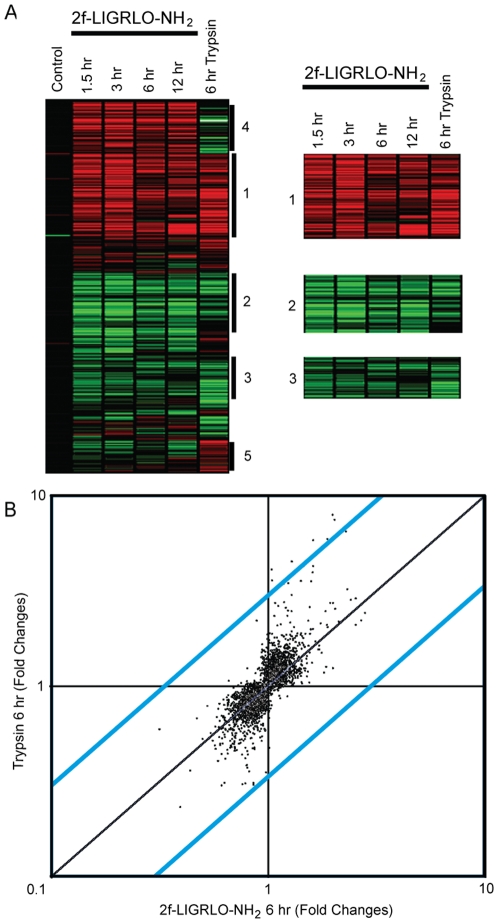
Microarray analysis of PAR2 induced gene expression.HEK293 cells were treated with either trypsin (50 nM) or 2f-LIGRLO-NH2 (1 µM). Total RNA was harvested at different time points after treatment (Trypsin, 6 h; Agonist, 1.5, 3, 6, 12 h). Control and treated cDNAs were hybridized to the ∼19,000 cDNA microchip and results were quantified, normalized and filtered as outlined in experimental procedures. (A) Heatmap (red, up-regulated; green, down-regulated) featuring 5 gene clusters. Three clusters show similar modulation by PAR2 peptide agonist and trypsin (1, 2, 3). Cluster 1 shows genes up-regulated by PAR2 activation, clusters 2 and 3 show genes suppressed by PAR2. Clusters 4 and 5 show opposing effects resulting from PAR2 peptide agonist versus trypsin. (B) Scatter plot of genes regulated by trypsin and PAR2 agonist peptide after 6 h treatment. Dots in right hand top quadrant are genes up-regulated by both trypsin and peptide, those in bottom left hand quadrant are genes down-regulated by both treatments. Blue lines depict regions where gene expression increased or decreased by≤3 fold.